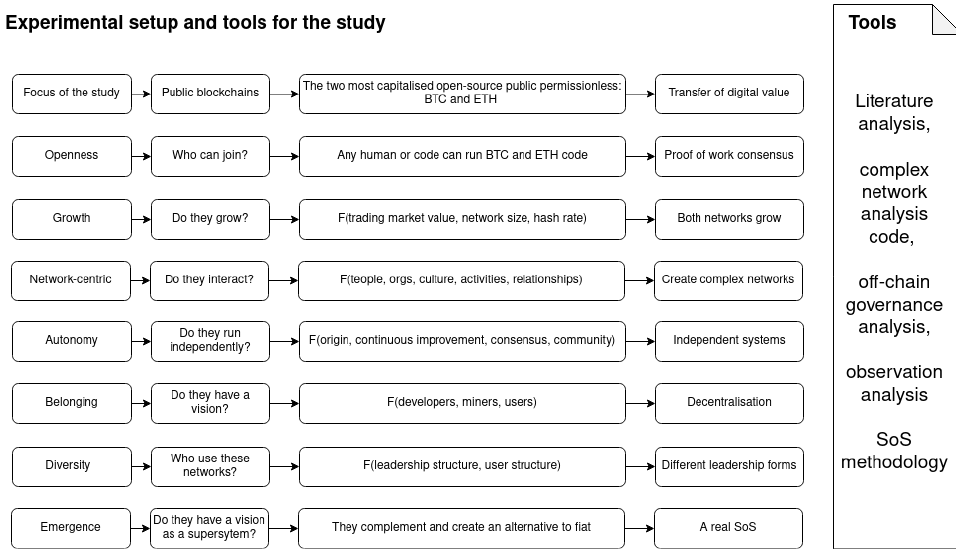
Figure 2. Experimental setup and tools for the